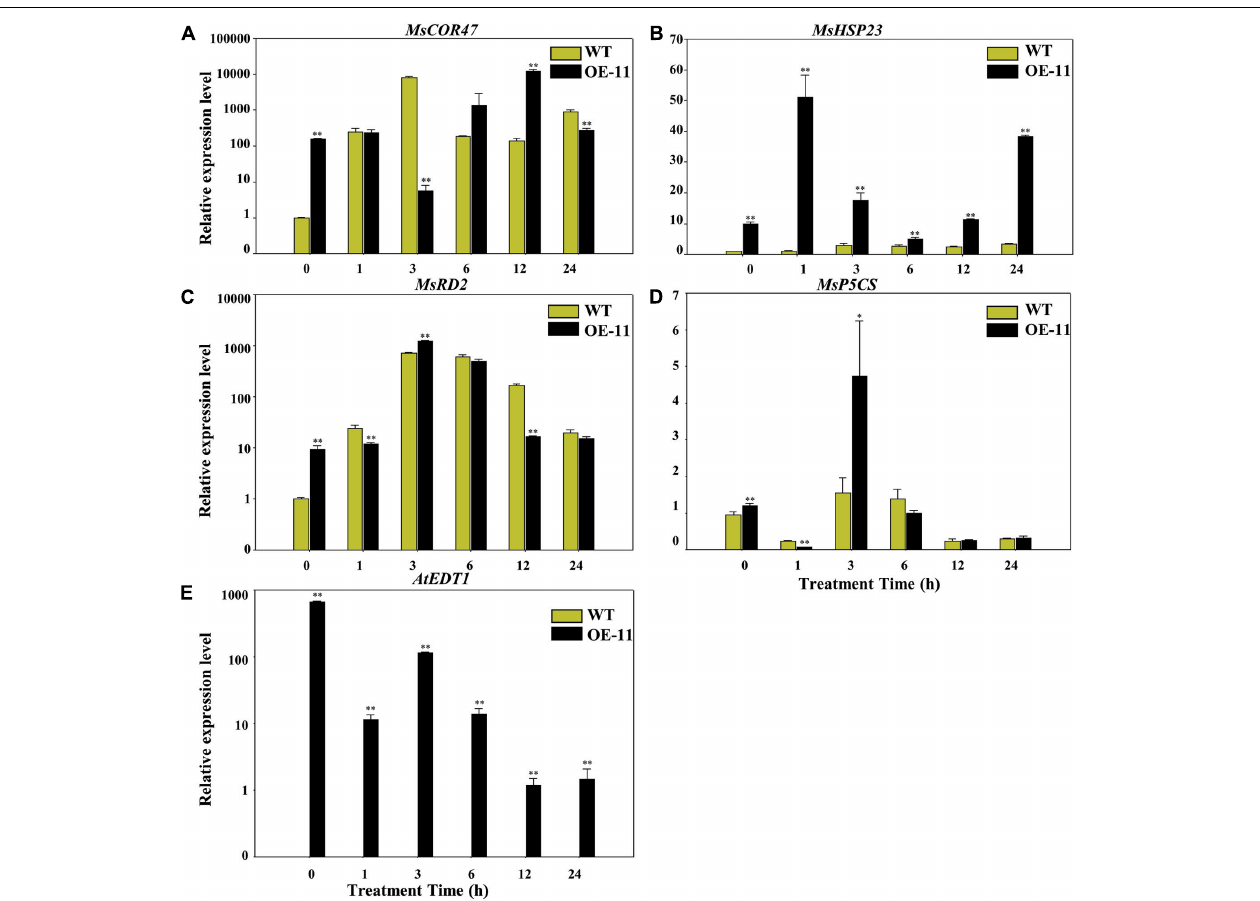
FIGURE 7 | Relative expression levels of drought-responsive genes in wild type and transgenic alfalfa as detected by qRT-PCR. Relative expression levels of MsCOR47 (A) , MsHSP23 (B) , MsRD2 (C) , MsP5CS (D) , and AtEDT1 (E) genes in wild type and transgenic alfalfa plants treated with 20% PEG6000 at time points of 0, 1, 3, 6, 12, and 24 h. Values are means ± SD of three replicates ( ∗ P < 0.05, ∗∗ P <